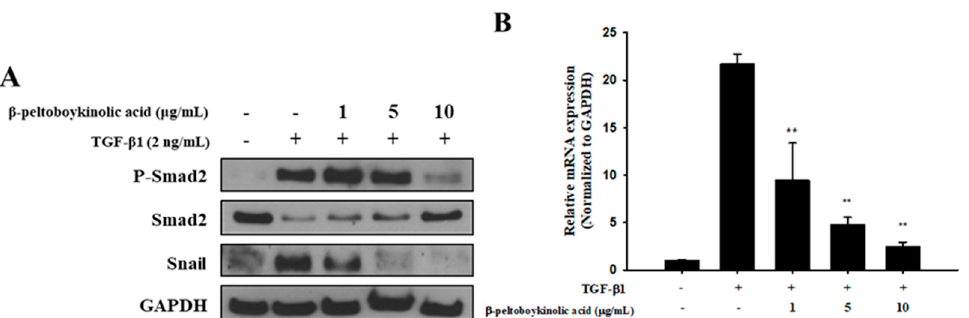
0.01 vs. the TGF- β 1-treated group.